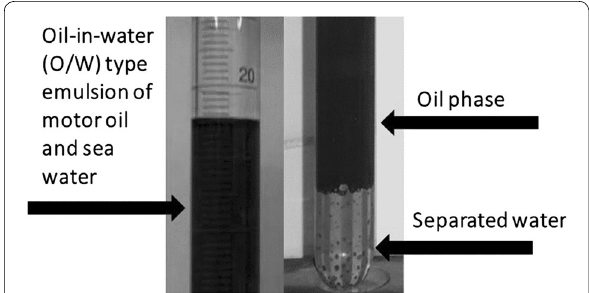
Fig. 1 Desestablization of motor oil emulsion by the biosurfactant from Bacillus sp.